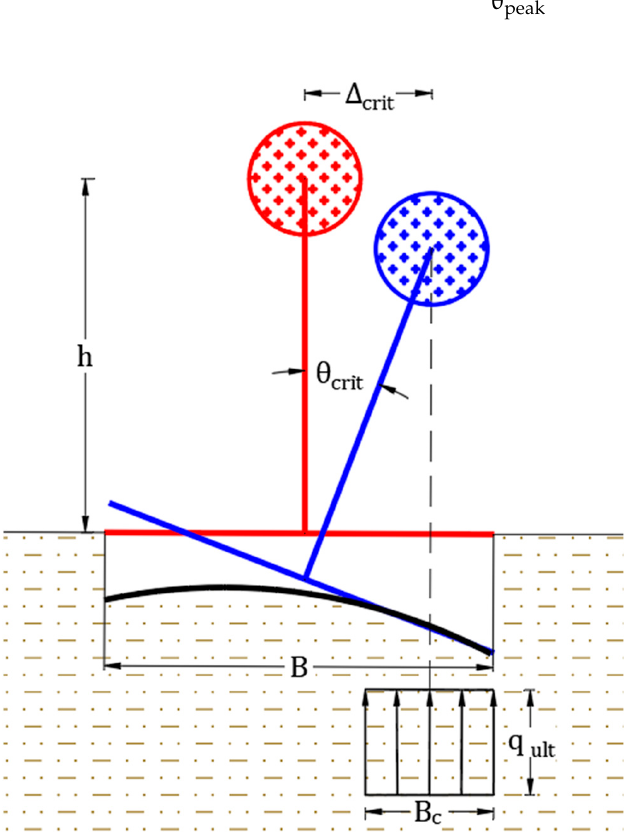
Figure 3. Illustration of a lumped mass–column–footing representation of a rocking system showing the critical rotation ( θ crit ), critical lateral displacement ( Δ crit ), and bearing pressure distribution (q ult ) along critical contact width (B c ) of the footing on the verge of tipping-over failure.